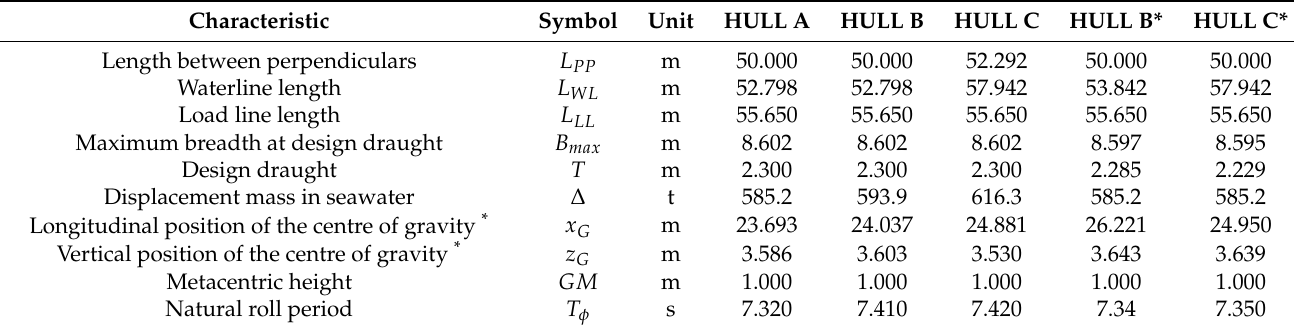
Table 3. Reference hulls’ main